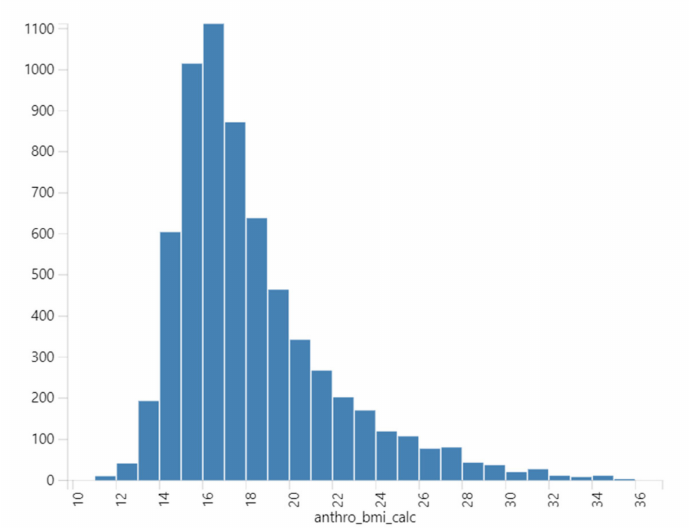
Figure A2. Distribution of our outcome.